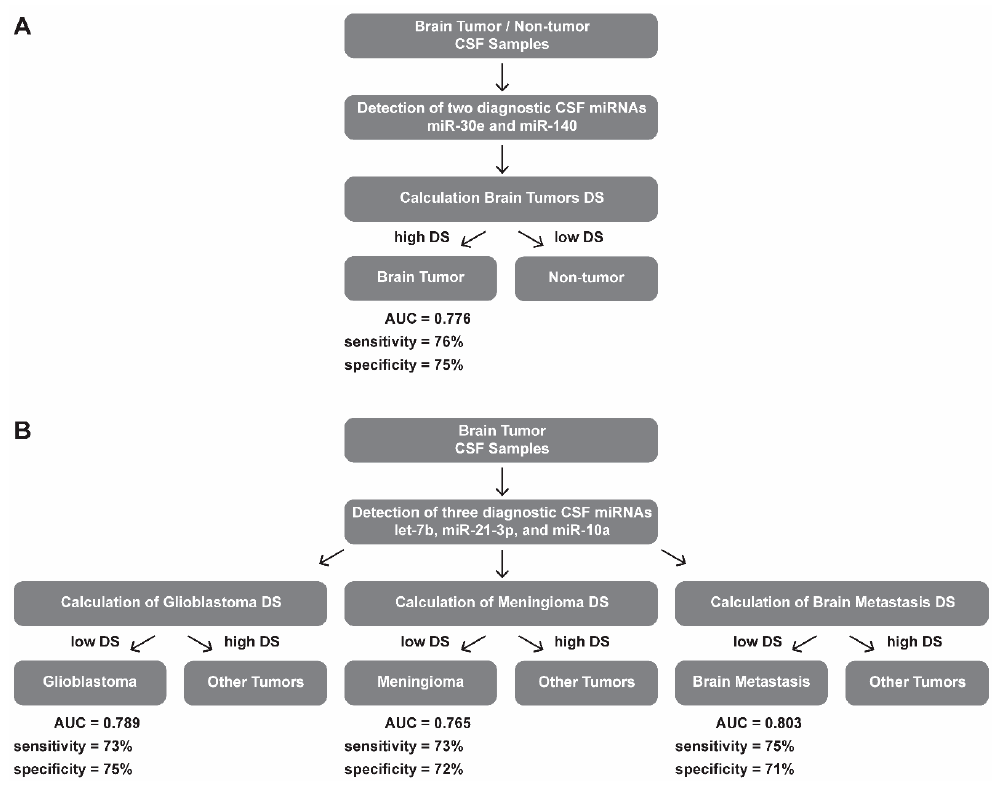
Figure 3. Diagnostic schemas for brain tumor patients stratification of ( A ) brain tumor and non-tumor patients; and ( B ) glioblastoma, meningioma and brain metastasis patients based on detection of selected miRNAs in CSF. DS = Diagnostic Score; AUC = Area Under Curve; and CSF = Cerebrospinal fluid.